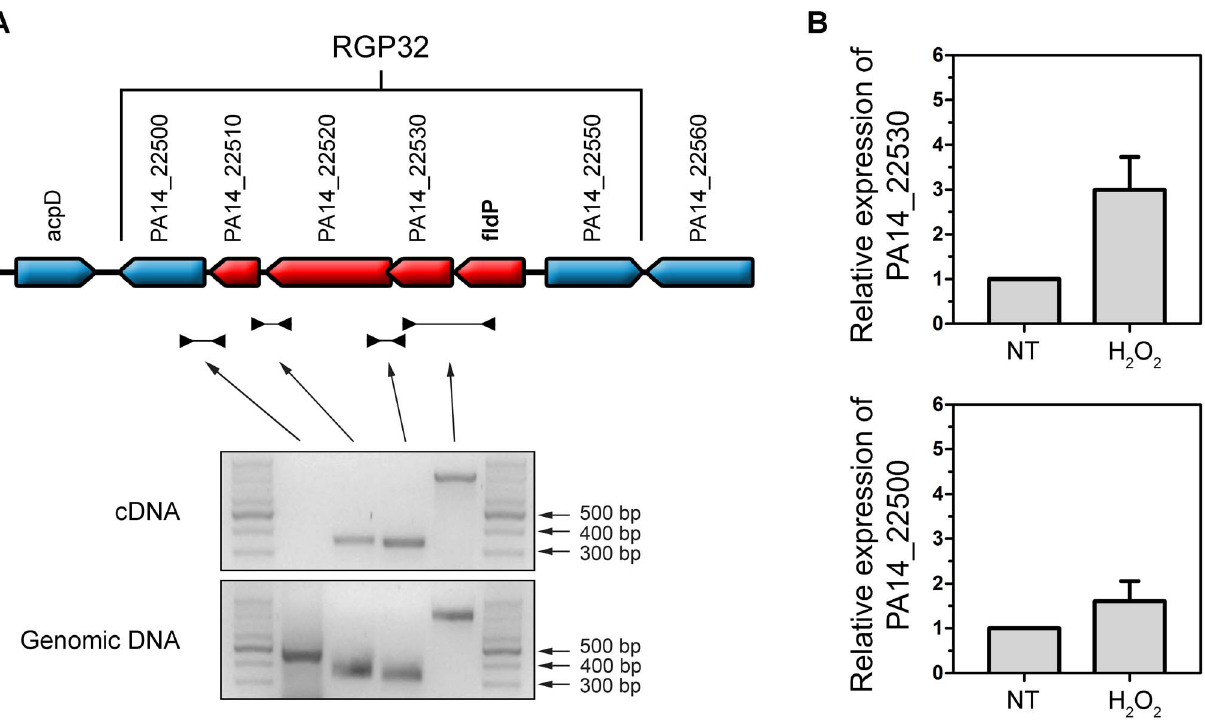
Figure 9. Transcriptional organization of RGP32. ( A ) The fldP gene is co-expressed with genes PA14_22530, PA14_22520 and PA14_22510 as a transcriptional unit, thereby constituting an operon (in red). Genes which are not co-transcribed with fldP are shown in blue. The gels below represent typical PCR amplifications obtained using cDNA or genomic DNA as templates. ( B ) Semi-quantitative RT-PCR was performed with specific primers for PA14_22530, which shows a H 2 O 2 -induced expression similar to that of fldP . This induction was not observed in PA14_22500, indicating that expression of this gene is independent from that of fldP . The rpoD transcripts were used as housekeeping controls. Bars represent relative expression levels averaged over two independent experiments (means 6 SEM), with expression of the untreated (NT) wt strain normalized to